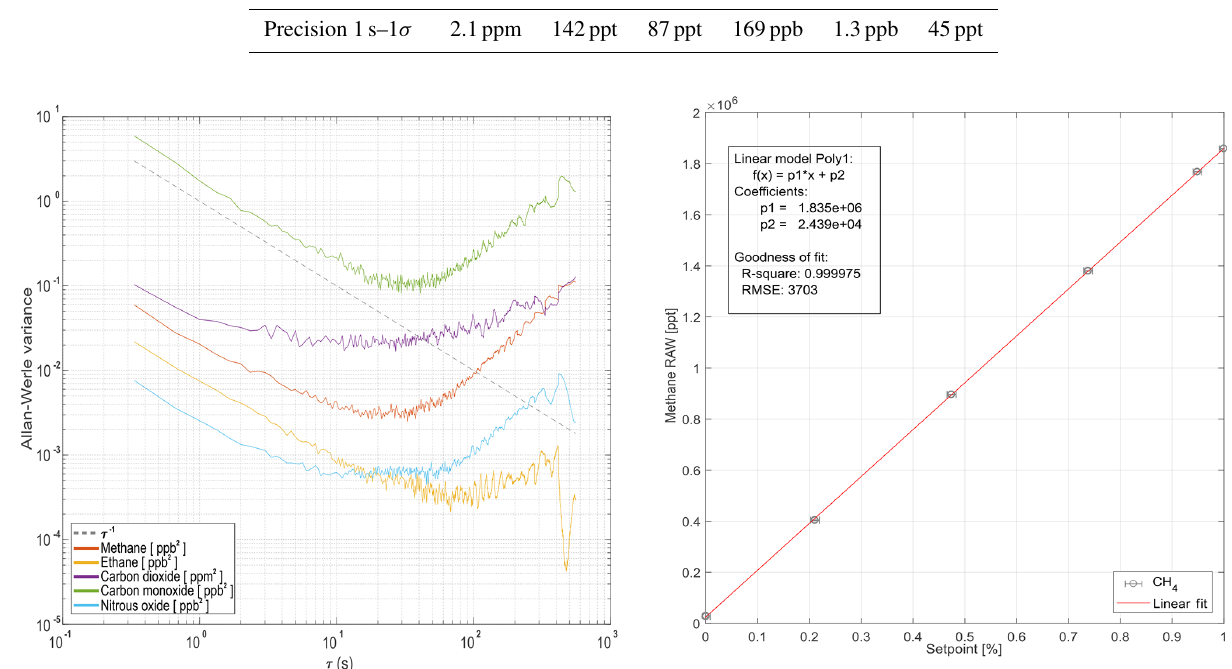
Figure 7. Allan–Werle variance for all measured chemical species during ground-based operation (a) . Panel (b) demonstrates linearity for methane is within achievable error bounds during ground-based operation using the online calibration gas mixing system from Sect.